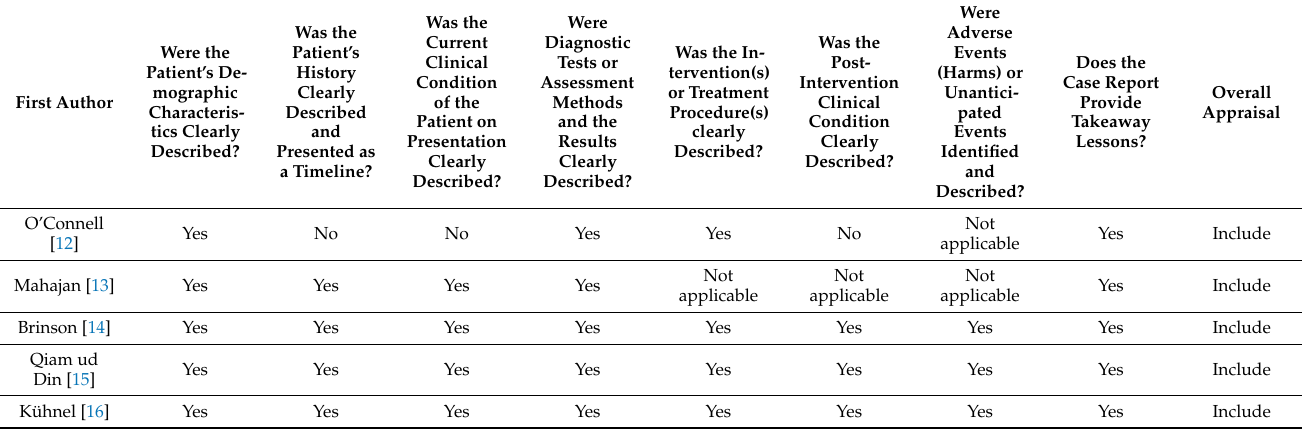
Table 4. Bias risk assessment. Possible answers to the questions: yes/no/unclear/not applicable. Possible overall